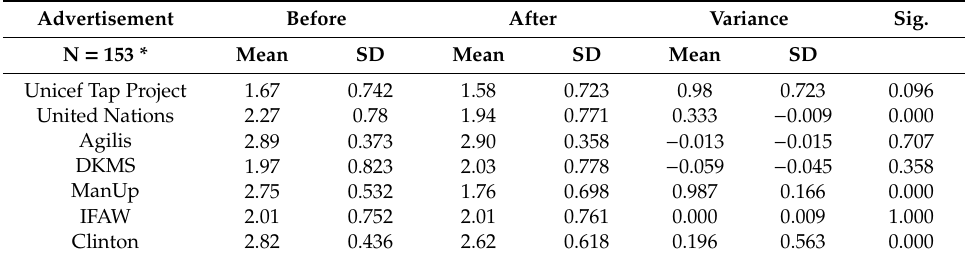
Table 6. Before and after mean, standard deviation, variance, and significance from the online survey for all 7 digital / social media